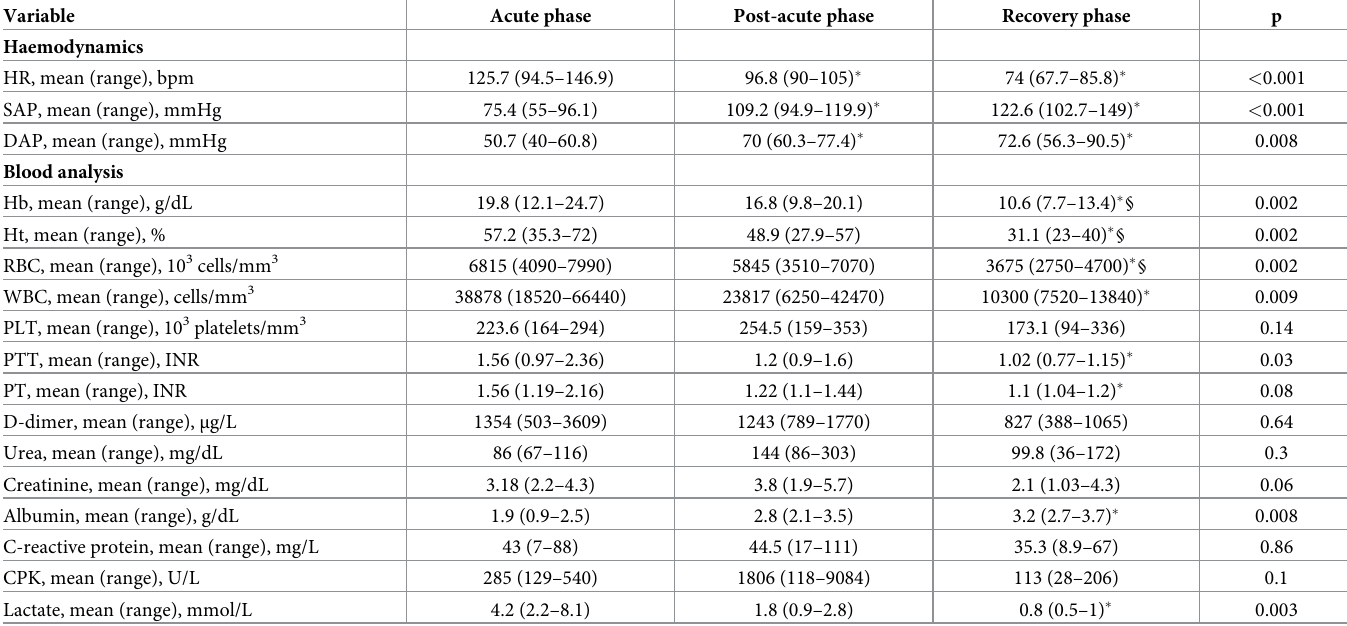
Table 1. Haemodynamic and laboratory analyses of ISCLS patients admitted to ICU because of shock.